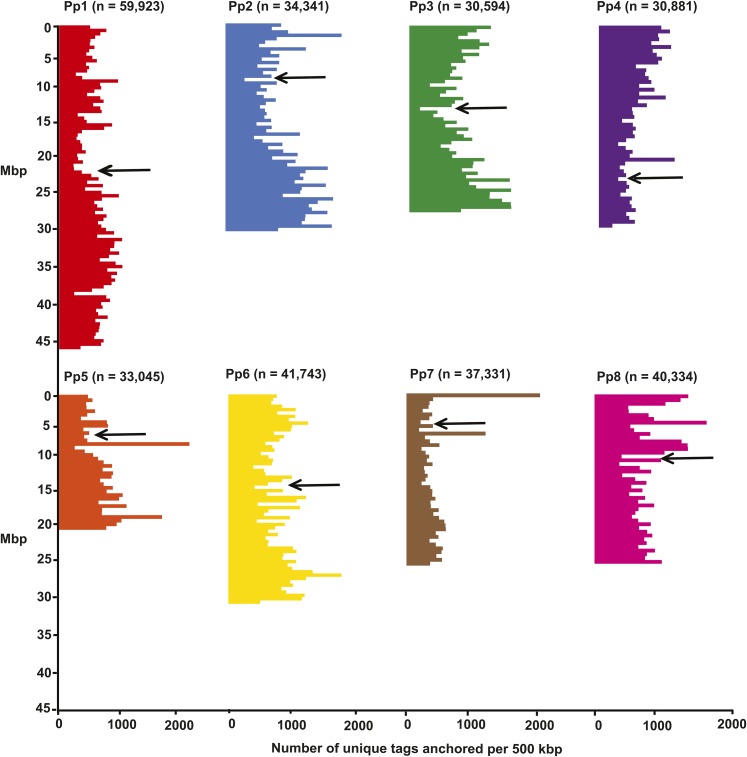
Anchoring of almond sequence tags to peach genome. Numbers of unique tags anchored to each 500-kbp region of each of the eight main scaffolds (Pp1–Pp8) of the peach whole genome sequence assembly v2.01a1. For each scaffold, the total number of unique tags is given in parentheses and the estimated position of the centromere is indicated with an arrow.